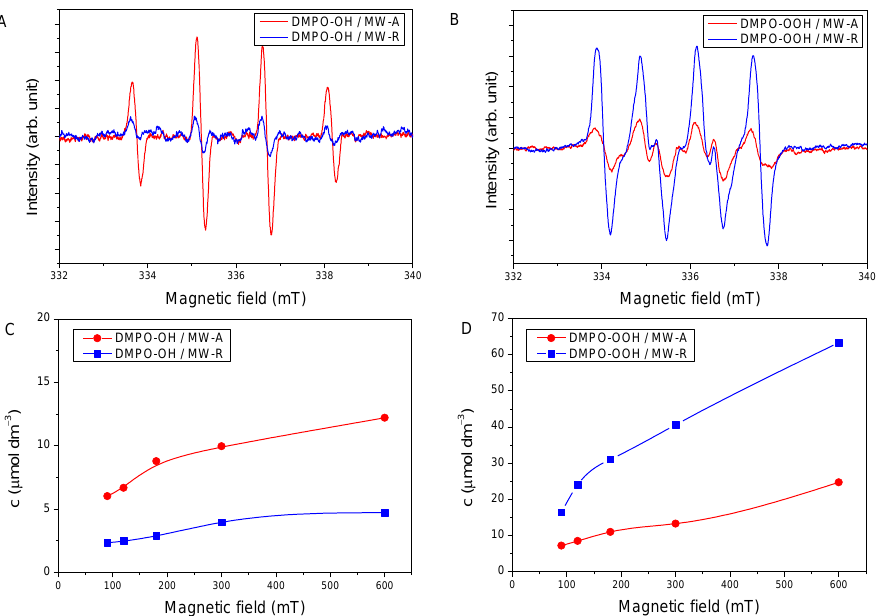
Figure 2. EPR spectra of DMPO-OH and DMPO-OOH adducts recorded in UV-irradiated disper- sion of MW-A ( A ); and MW-R ( B ) at 300 s. Kinetic curves of the formation of DMPO-OH ( C ); and DMPO-OOH ( D ) adducts using MW-A and MW-R samples.